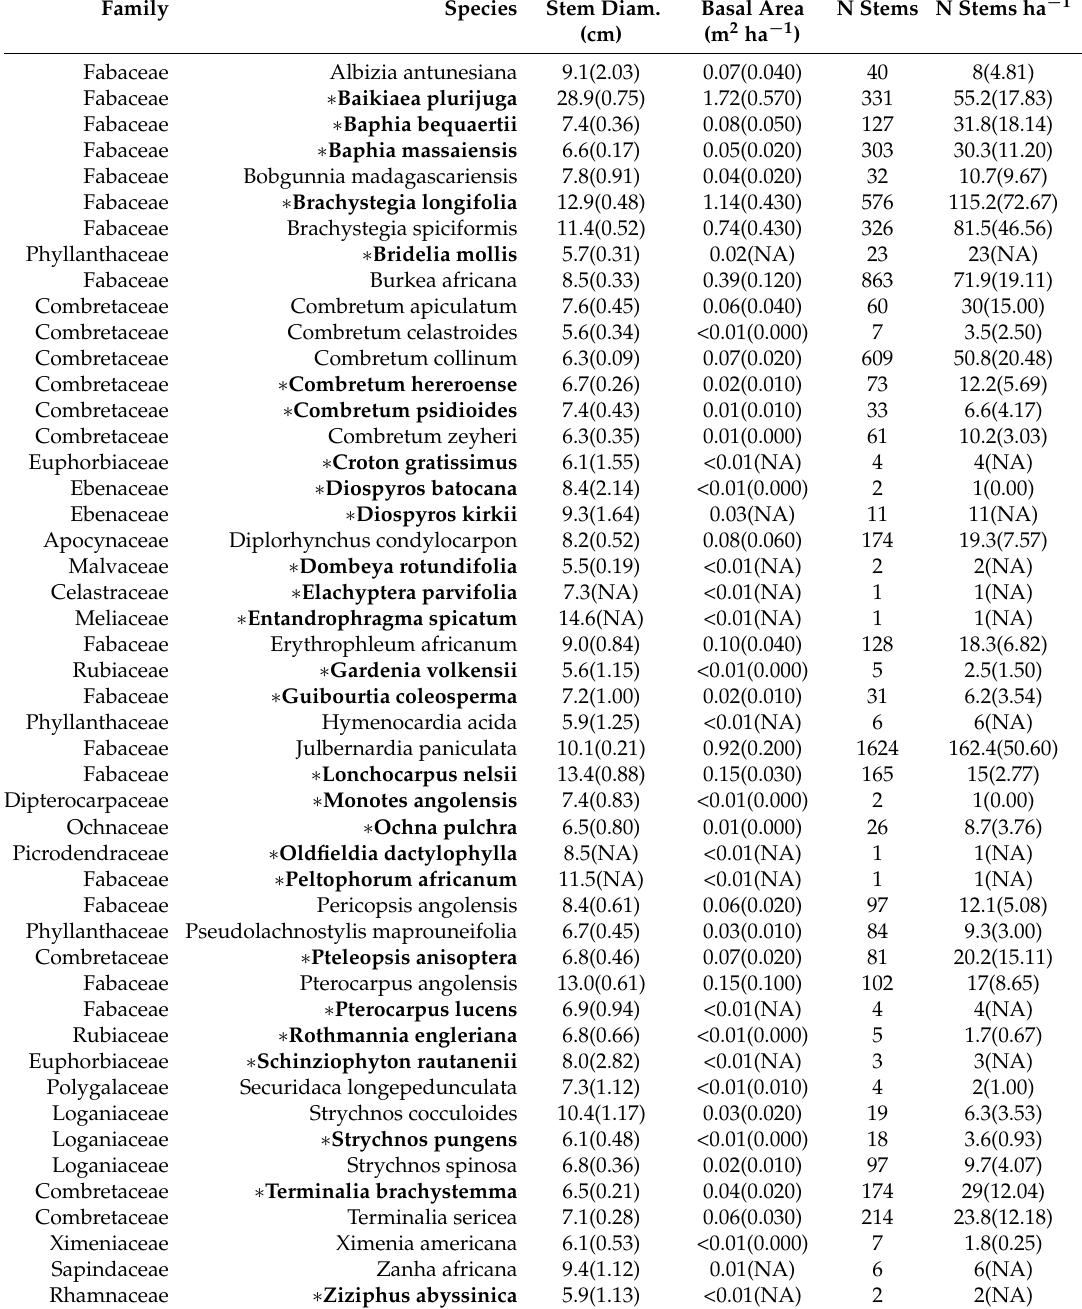
Table 2. Species found in one hectare plots in Bicuar National Park. Stem diameter and basal area are the mean of all stems with the standard error of the mean in parentheses. Number of stems per hectare is the mean of the number of stems in all one hectare plots where stems of that species are present with the standard error of the mean in parentheses. Species found only in Bicuar National Park are marked in bold text with an